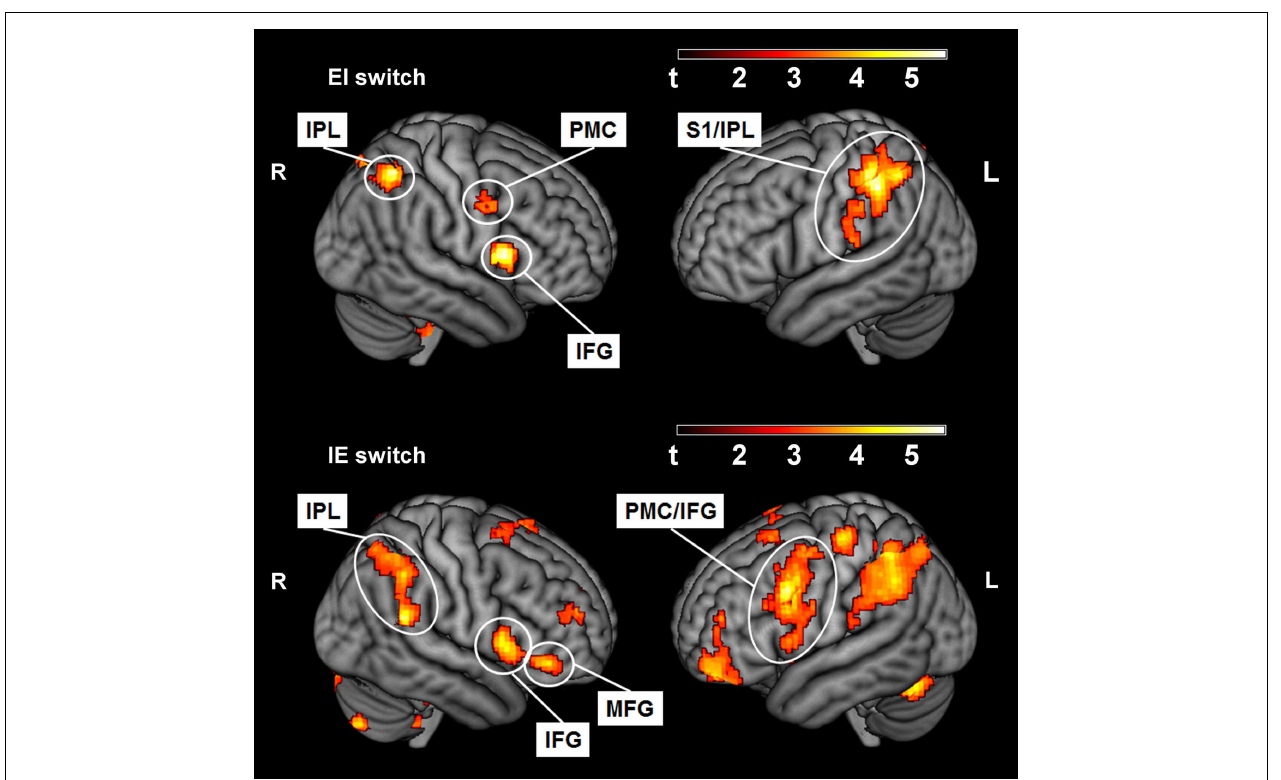
(the dorsal part, excluding the supramarginal and angular gyri); PMC, premotor cortex (in precentral gyrus); S1, primary somatosensory cortex (postcentral gyrus); IFG, Inferior frontal gyrus, opercular part; MFG, Middle frontal gyrus (excluding the orbital